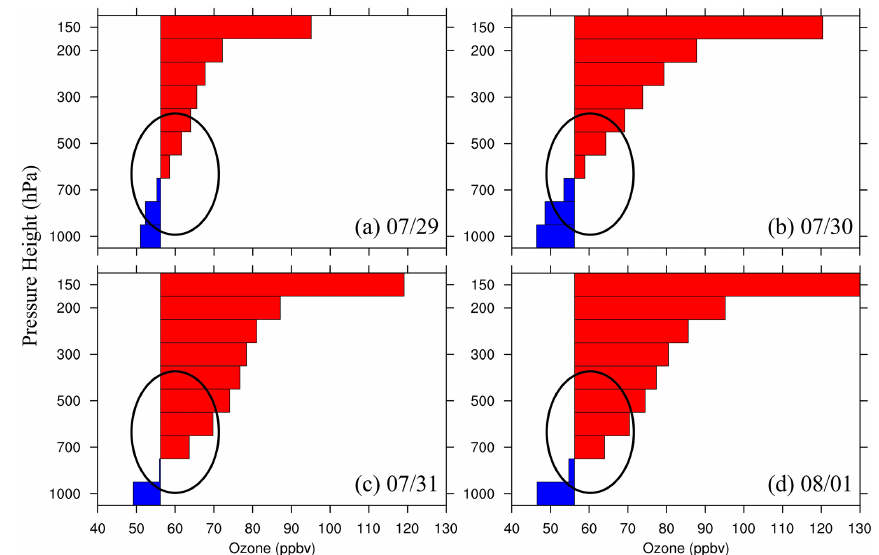
Figure 7. Spatially averaged profiles of ozone concentrations (unit: ppbv) over the NCP from the TROPESS AIRS L2 ozone products on (a) 29 July, (b) 30 July, (c) 31 July, and (d) 1 August 2021, all indicated as month/day at the bottom right corners. The 10d averaged ozone concentrations between the surface and 700hPa over the NCP are used as the baseline, and positive (negative) departure from the 10d averaged concentrations is shown in red (blue)